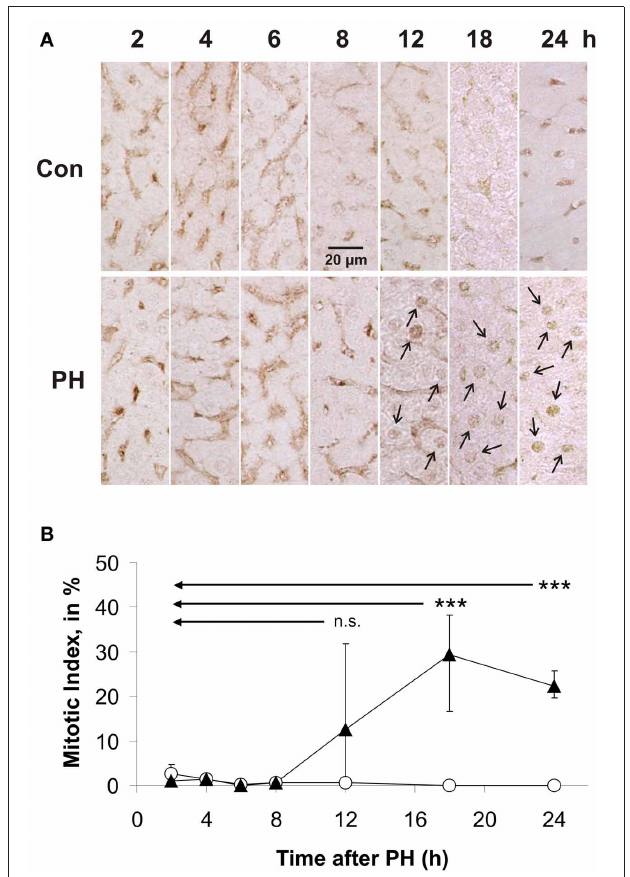
FIGURE 1 | Immune histochemical detection and quantification of proliferating cell nuclear antigen (PCNA) in paraffin sections of rat liver obtained during or at different times after partial hepatectomy. PCNA-positive cells were counted in images of PCNA-antibody labeled liver sections. Data were obtained from images of control tissue prepared during initial surgery and from images of experimental tissue samples obtained during the second operation at different times after PH. (A) Representative example images of control tissue (Con) and residual liver tissue at 2, 4, 6, 8, 12, 18, or 24h after partial hepatectomy (PH), respectively, are shown. Examples of PCNA-positive nuclei are labeled by arrows. (B) Number of hepatocytes showing PCNA-positive nuclei normalized to the total number of cells in the image in % (mitotic index). Data of the Con-time series are labeled with open circles, those of the hepatectomized animals (PH) with triangles. Means and standard deviations were calculated from results of tissue preparations from n = 4 different animals (6 counting replicates for each n ) (n.s., p ≥ 0 . 05; ∗∗∗ p < 0 . 001).